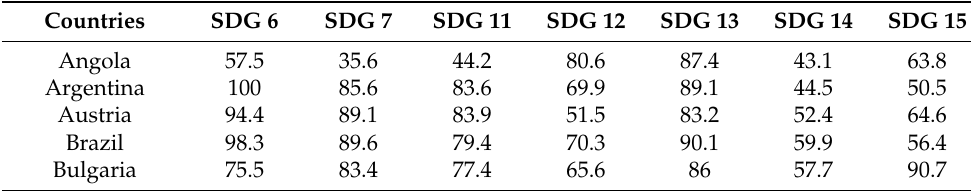
Table A2. Values of Environmental